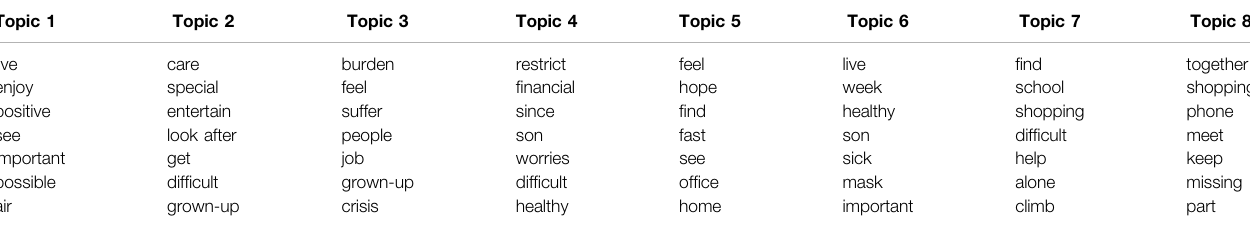
TABLE 3 | Topics of single parents (n (cid:1)